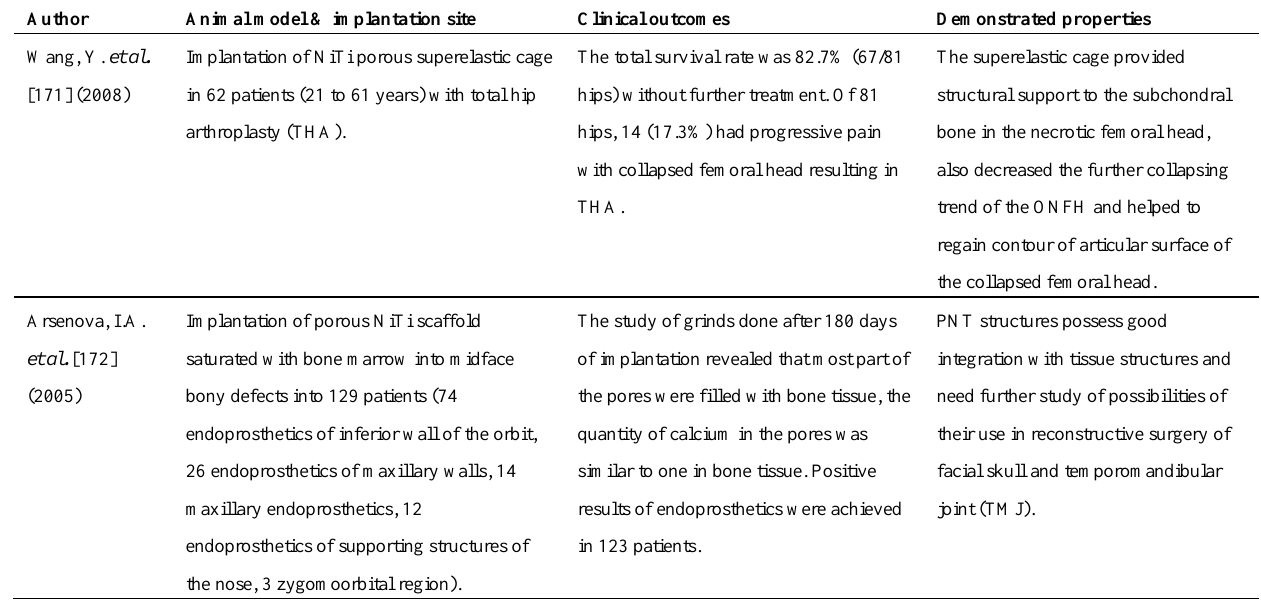
Table 12. Clinical studies using NiTi